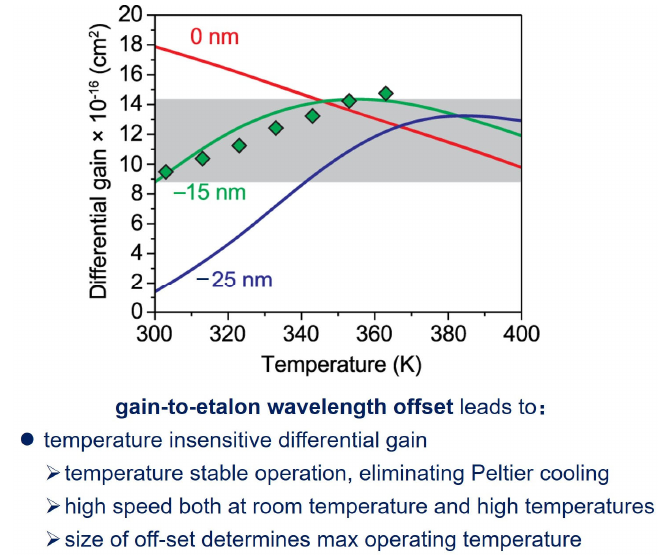
Figure 7. Differential gain versus temperature for 300 K gain-to-etalon wavelength offsets of 0, − 15, and − 25 nm. The lines are calculated results based on 8-band k · p theory, and the diamonds are experimental results extracted from small signal measurements of 980 nm VCSELs [48].